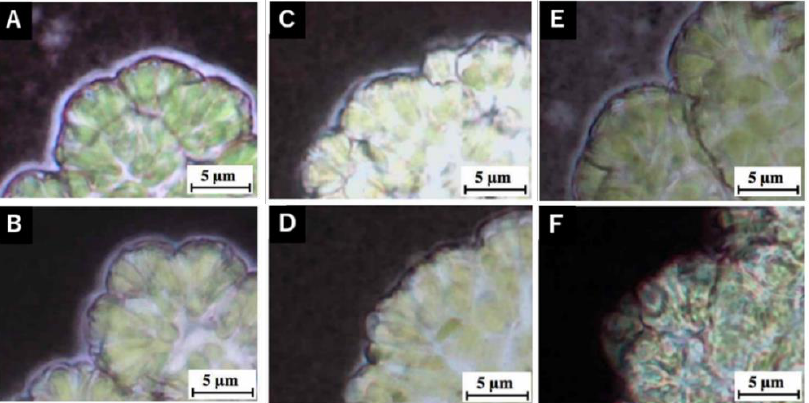
Figure 4. Optical microscope image of algal slurry of Showa strain mixed with India ink. ( A ), no treatment; ( B ), 9th hot-water rinsing at 60 °C; ( C ), 5th hot-water rinsing at 70 °C; ( D ), 9th hot-water rinsing at 70 °C; ( E ), heat treatment at 80 °C; ( F ), heat treatment at 85 °C.